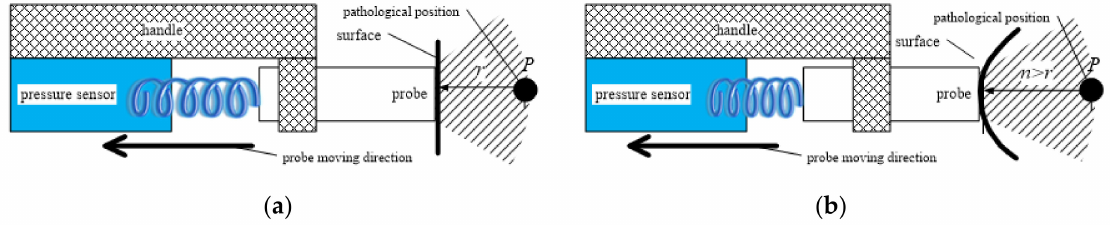
Figure 8. The probe with a pressure sensor. ( a ) Surface is not squeezed; ( b ) Surface is squeezed.